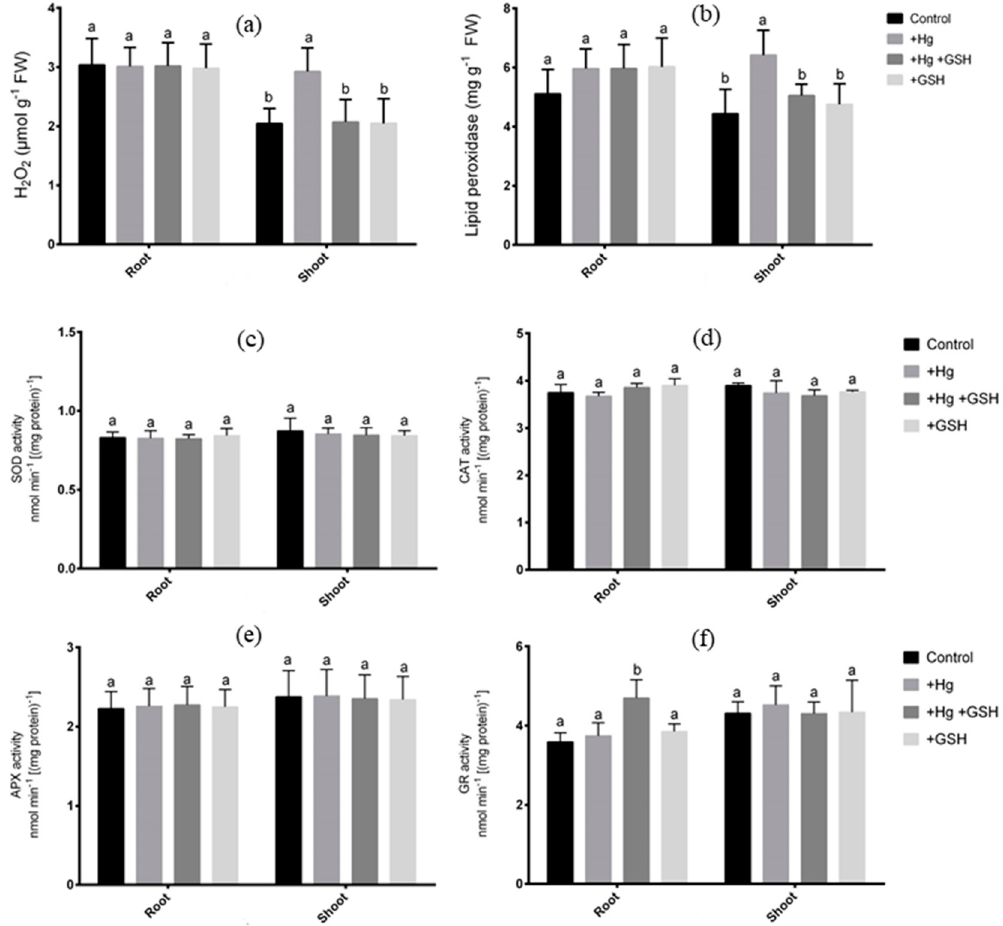
Figure 7. Changes in different ROS indicators and antioxidant enzymes in root and shoot of alfalfa. Response of H 2 O 2 ( a ), lipid peroxidation ( b ), SOD ( c ), CAT ( d ), APX ( e ) and GR ( f ) in alfalfa cultivated in different conditions of Hg and GSH: +Hg (40 μ M), +Hg+GSH (40 μ M Hg+50 μ M GSH), and +GSH (50 μ M GSH). Data represent means ± SD of three independent biological samples. Different letters indicate a significant difference at the p < 0.05 level.